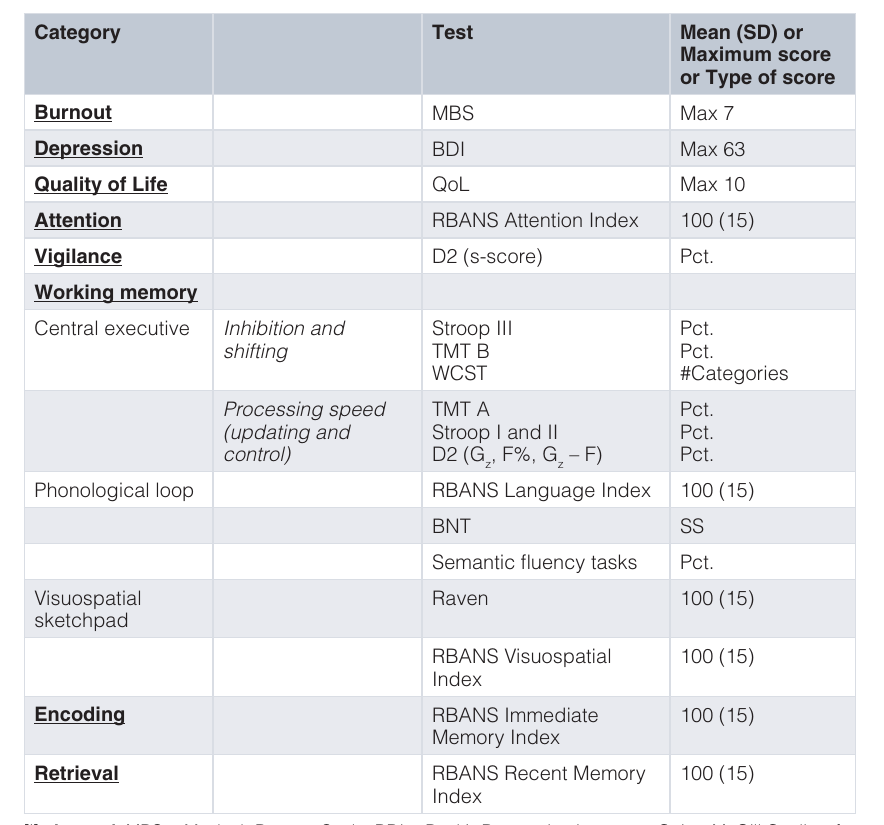
Table 1. Overview of the different tests for measuring relevant impaired functions accompanying